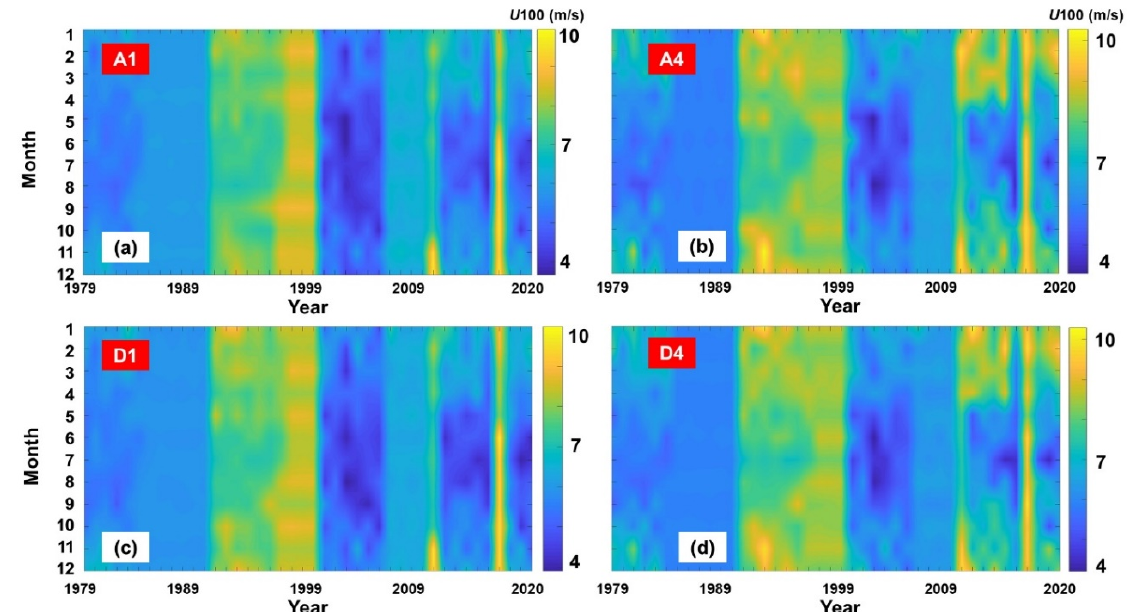
Figure 6. Monthly and annual distribution of the U 100 (average values) reported between January 1979 and December 2020; ( a ) site A1; ( b ) site A4; ( c ) site D1; ( d ) site D4.